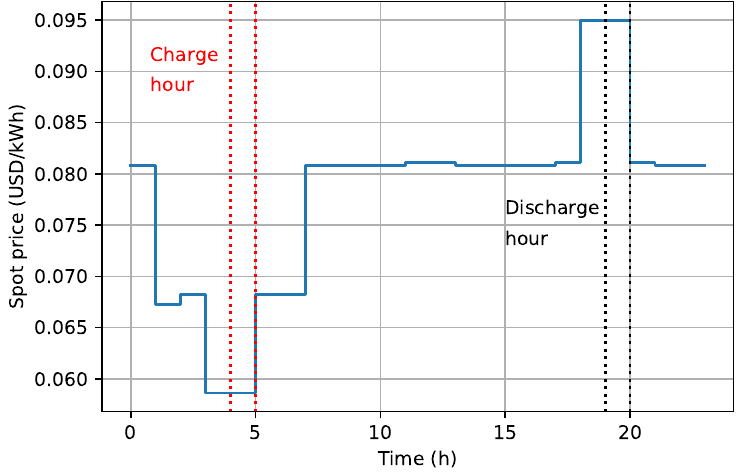
Figure 7. Operating hours for the statistical-based operating